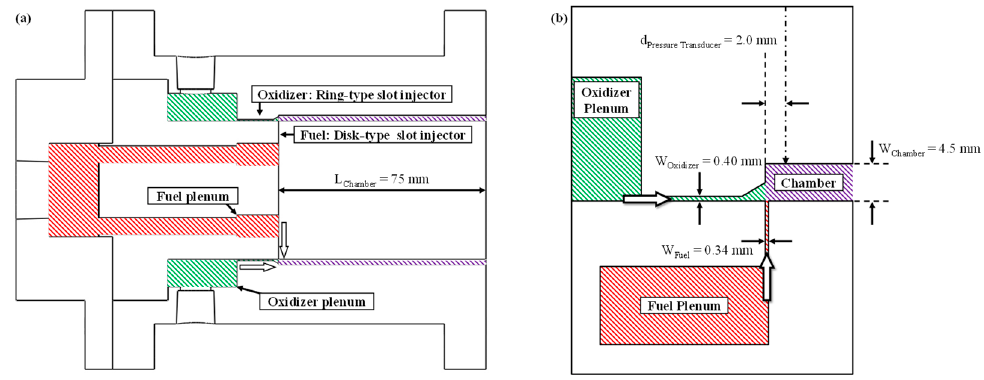
Figure 3. ( a ) Longitudinal cross-section of the tri-arc/circular RDEs, ( b ) details of fuel and oxidizer injectors. Table 1. Geometric dimensions for the tri-arc and circular RDEs.